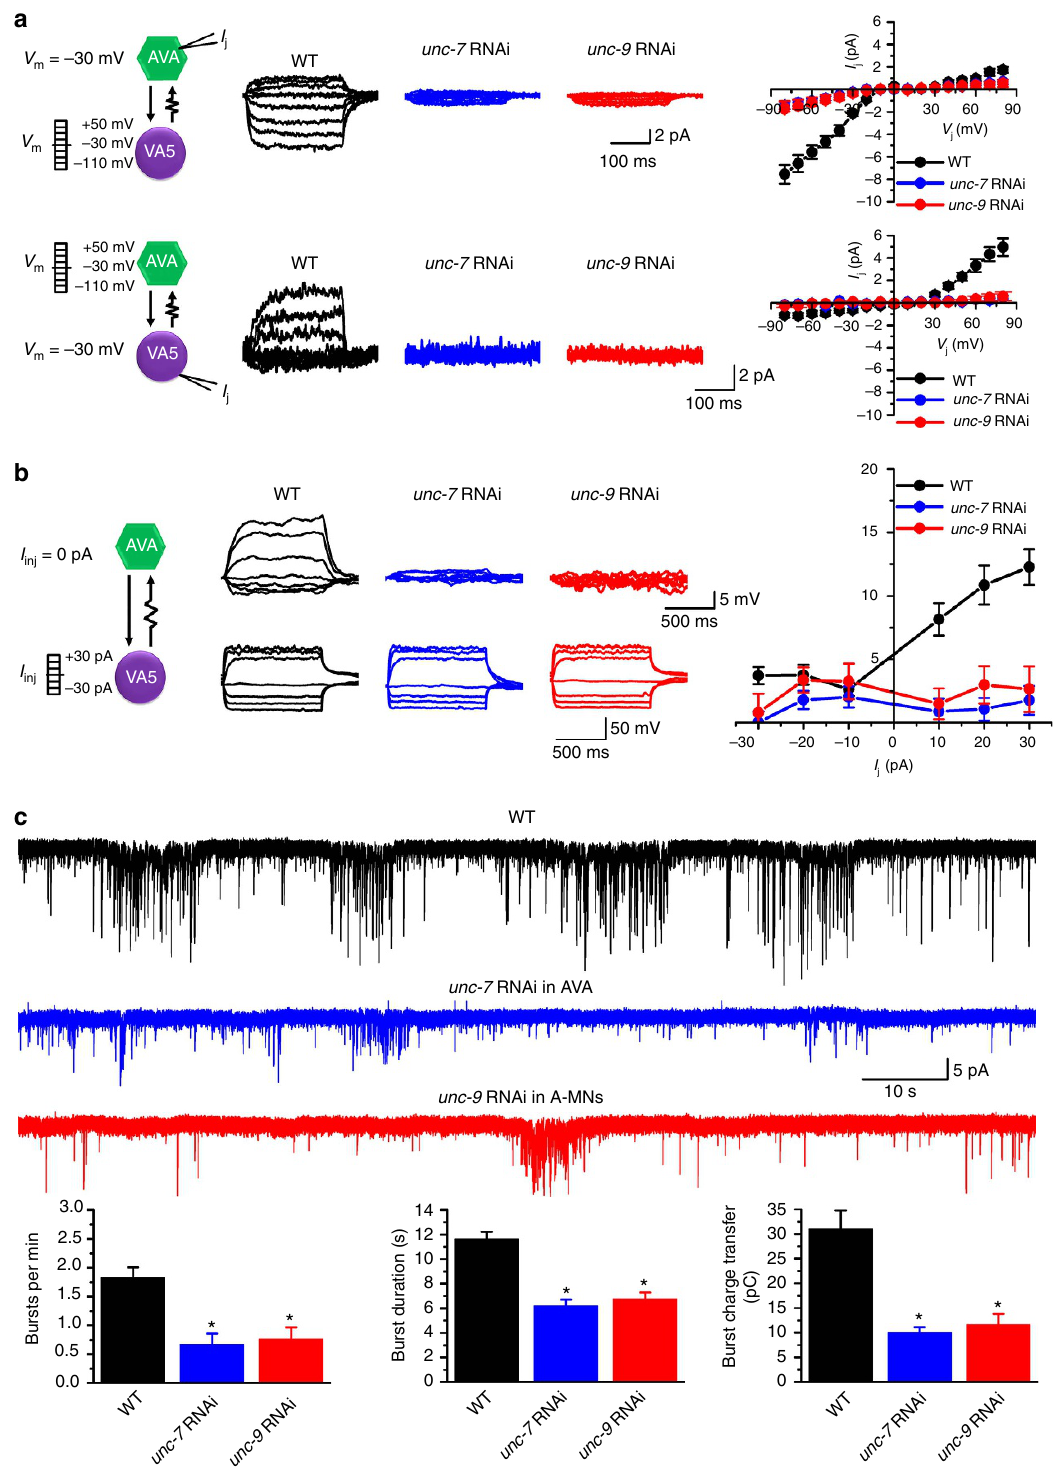
Figure 7 | Deficient electrical coupling inhibits chemical synaptic transmission between AVA and VA5. ( a ) Knockdown of either unc-7 specifically in AVA or unc-9 specifically in A-type cholinergic motor neurons essentially abolishes junctional current ( I j ) between AVA and VA5. I j was recorded from one neuron held constantly at (cid:2) 30mV (neuron #1) while the other neuron (neuron #2) was stepped to various membrane voltage ( V m ) from a holding voltage of (cid:2) 30mV. V j ¼ V m of neuron #1 (cid:2) V m of neuron #2. Whole-cell membrane currents of the neuron receiving the voltage steps are not shown for clarity. ( b ) Current injections ( I inj ) into VA5 cause V m changes in AVA of wild type but not of either the unc-7 or the unc-9 knockdown strain. In both a , b , n was 10 wild type (WT), 7 unc-7 RNAi and 8 unc-9 RNAi. ( c ) PSC bursts recorded from VA5 are greatly inhibited in either the unc-7 ( n ¼ 7) or unc-9 ( n ¼ 7) knockdown strain compared with WT ( n ¼ 12). Data are shown as mean ± s.e. The asterisk (*) indicates a statistically significant difference compared with WT ( P o 0.05, one-way ANOVA followed by Tukey’s HSD